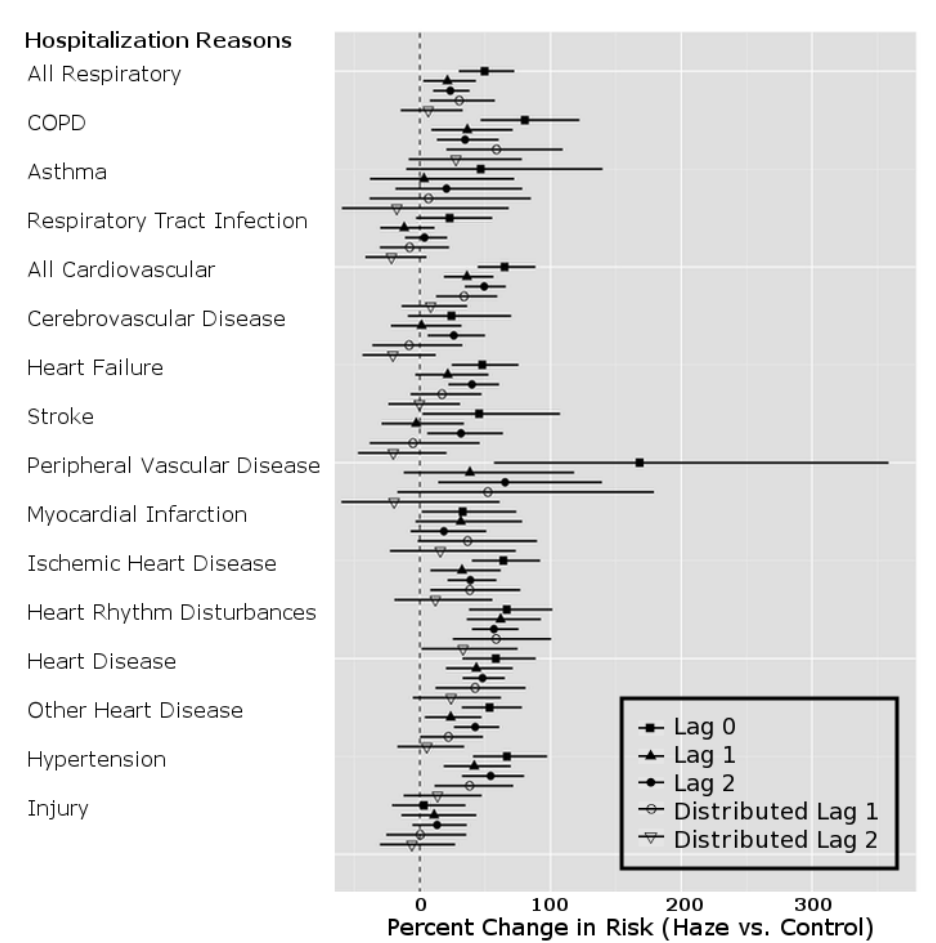
Figure 4. Percent change and 95% CI in hospital related admissions for the haze period compared to the non-haze period in the affected region controlling for PM and dew